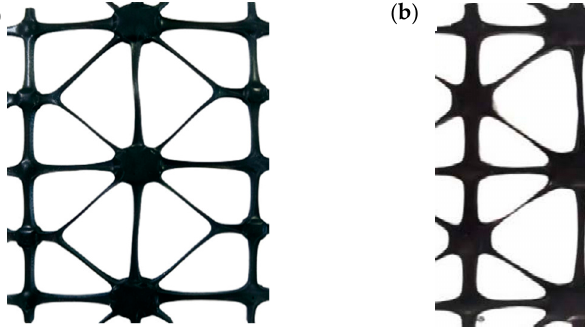
Figure 8. Performance-optimized multi-axial geogrid of other pre-punched holes. ( a ) Circular-diamond holes, ( b ) Circular-triangle holes, ( c ) Circular-semicircular holes.